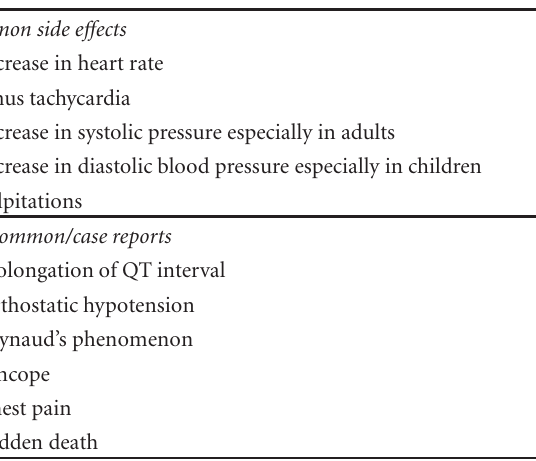
Table 1: Cardiovascular side e ff ects of atomoxetine (Strattera) [1, 2, 5,